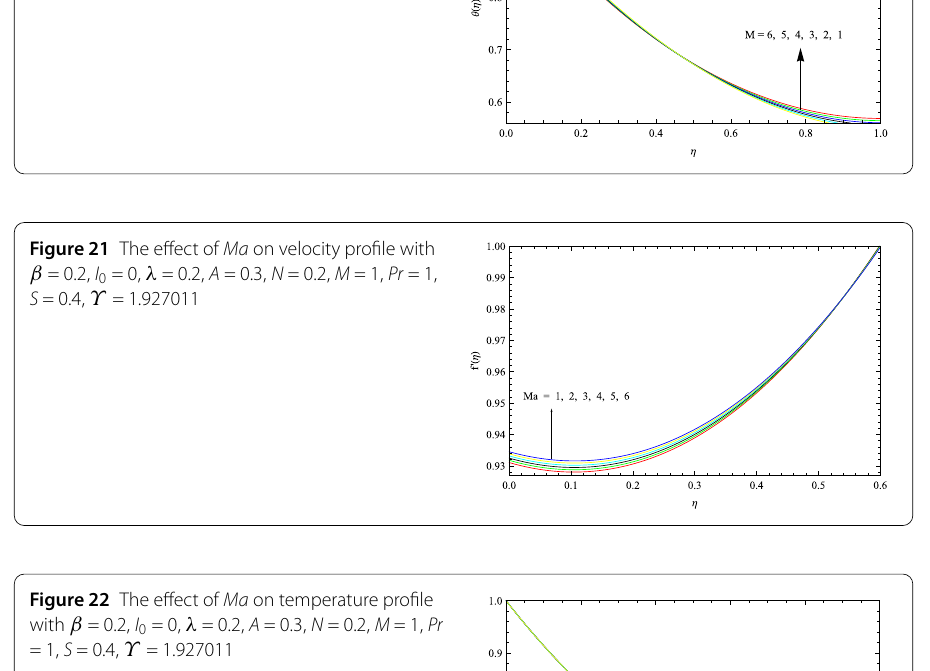
Figure 20 The effect of M on temperature profile with β = 0.2, I 0 = 0, λ = 0.2, A = 0.3, N = 0.2, Ma = 1, Pr = 1, S = 0.4, Υ = 1.927011